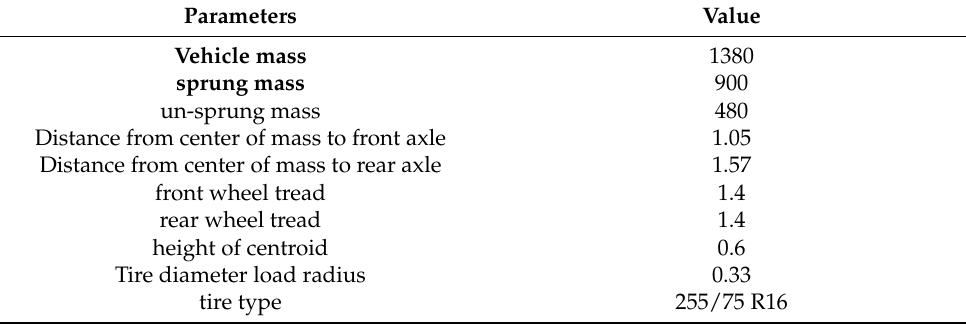
Table 4. Main parameters of vehicle